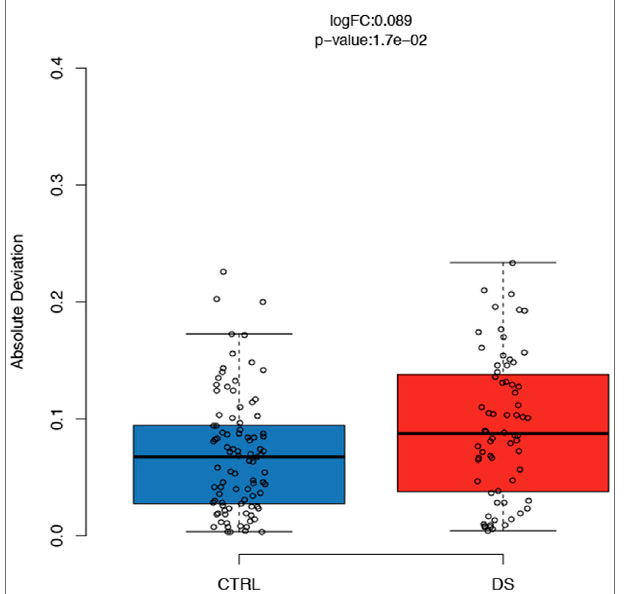
FIGURE 5 | DNAm variability of the rDNA promoter in persons with DS. For CpG2 of RiboProm_1 , the boxplots report absolute deviation values of DNAm in persons with DS and controls. LogFC and p -values were calculated using the R package varFit.